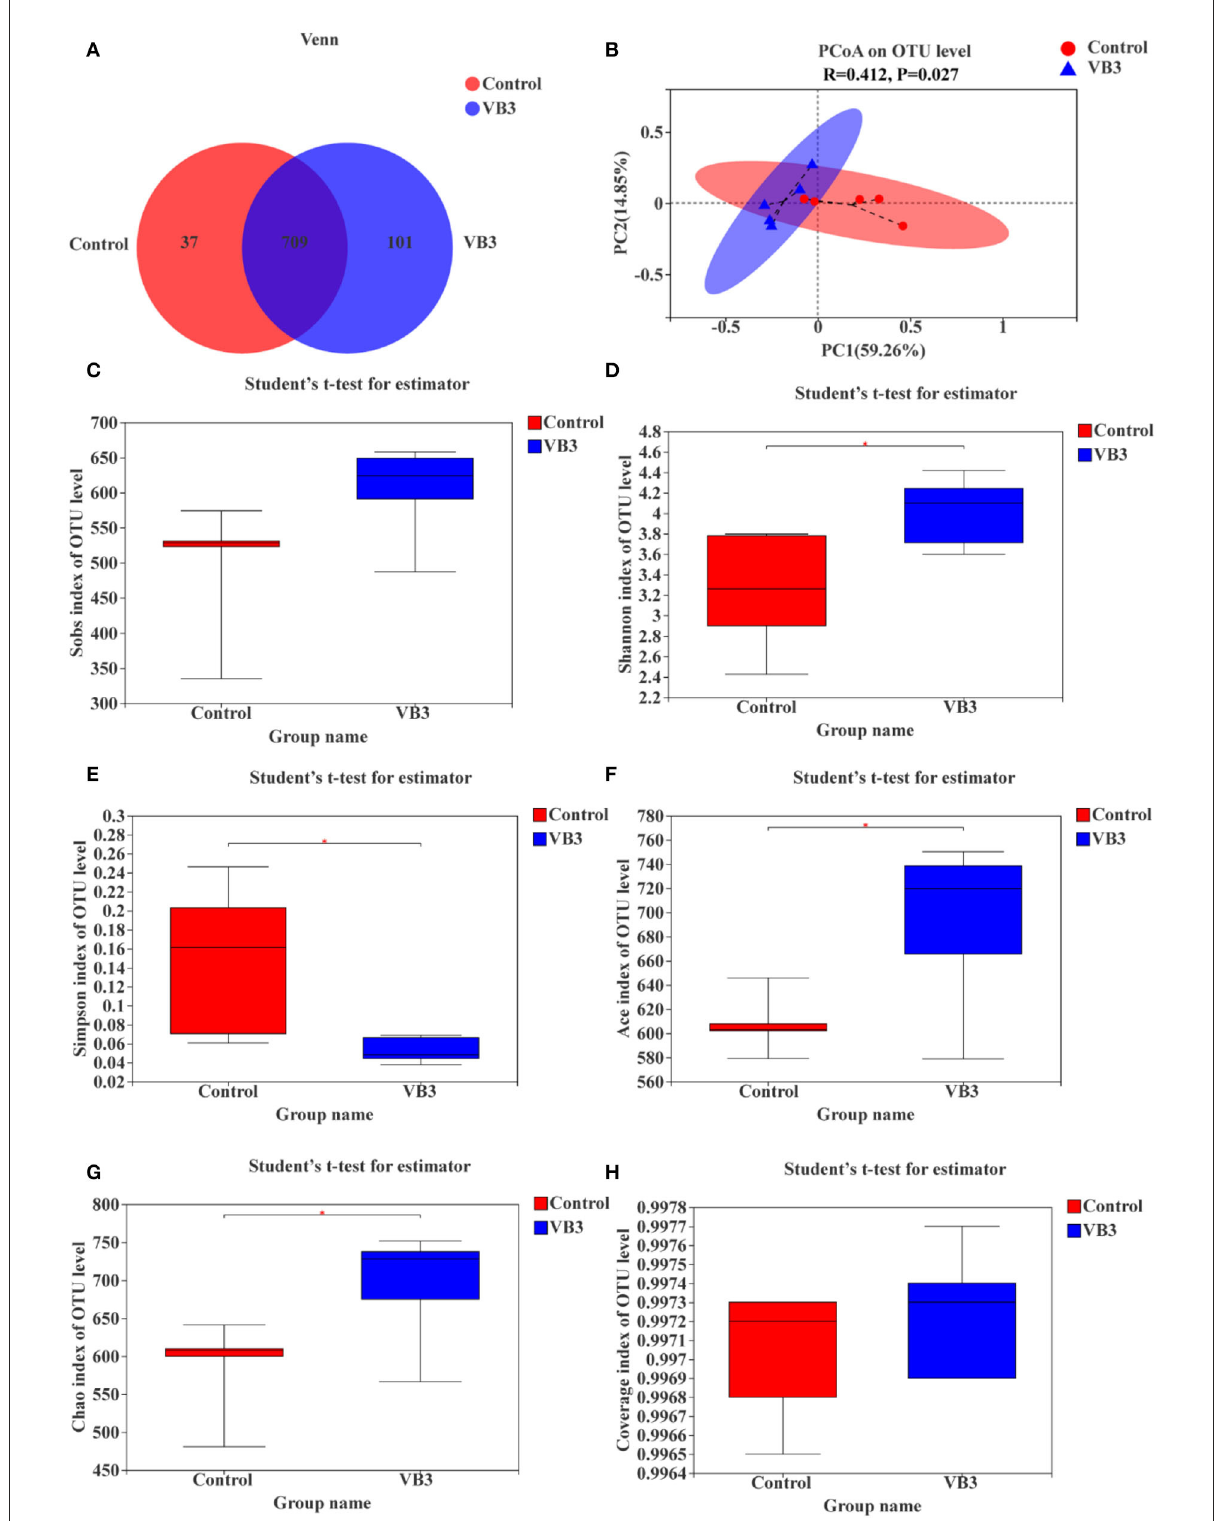
FIGURE1 OTUs analysis, β -diversity estimation, and α -diversity analysis between the experimental group (VB3) and control group (Control). (A) Venn diagram based on OTU. (B) PCoA for β -diversity estimation. (C–H) Box plot of alpha diversity [ (C) observed species number; (D) Shannon’s index; (E) Simpson’s index; (F) ACE index; (G) Chao1 index; (H) coverage index]. * P <